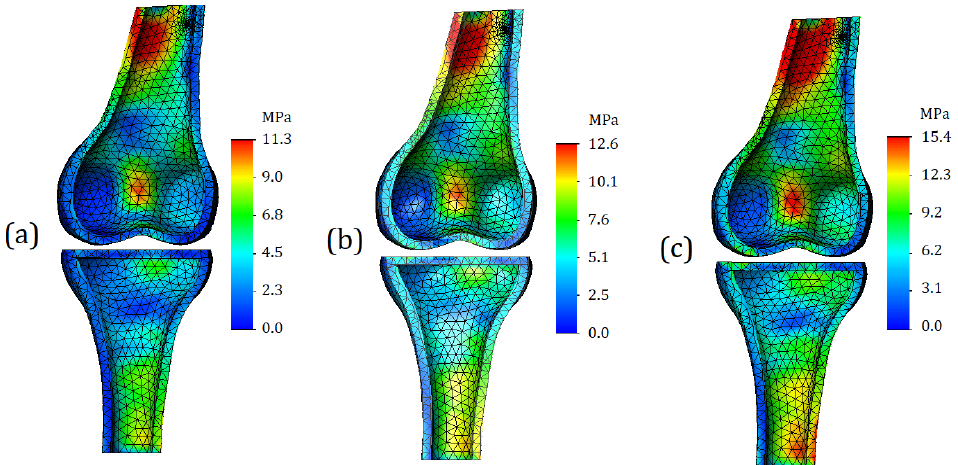
Figure 7. Von Mises stress plots on cortical bone section view in case of walking: ( a ) With mild cartilage sti ff ness; ( b ) With moderate cartilage sti ff ness; ( c ) With severe cartilage sti ff ness.